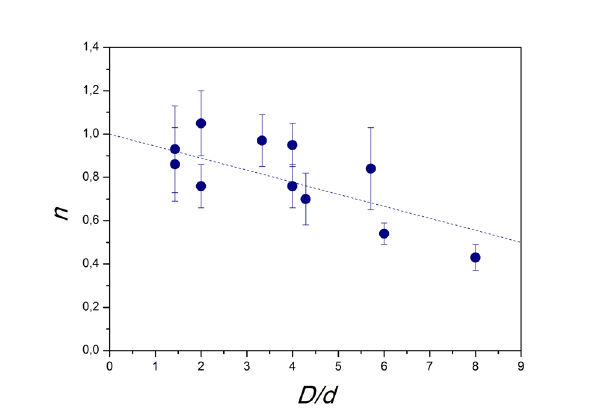
Figure 5. Plot of the exponent n of the divergence law in Eq.(1) versus the ratio D d of the injection width to the bead diameter. The dashed blue line stands for the linear relation given in